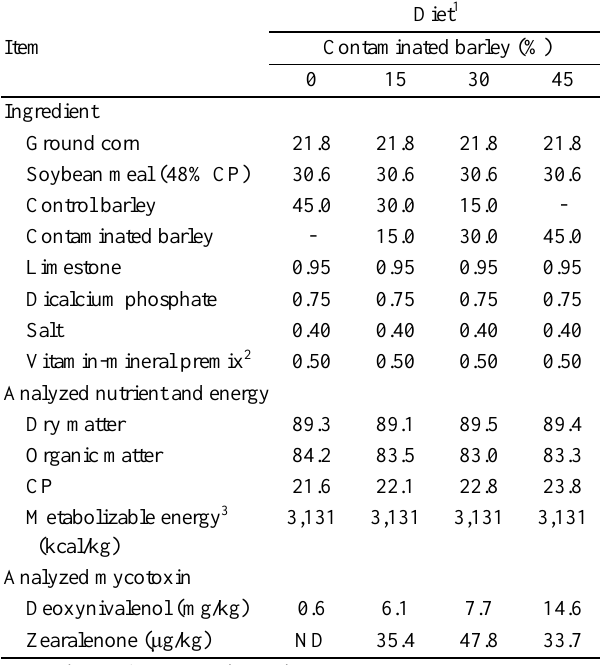
Table 2. Ingredient and nutrient composition (%) of experimental diets containing increasing levels of barley contaminated with Fusarium mycotoxins (as-fed basis), Exp. 1